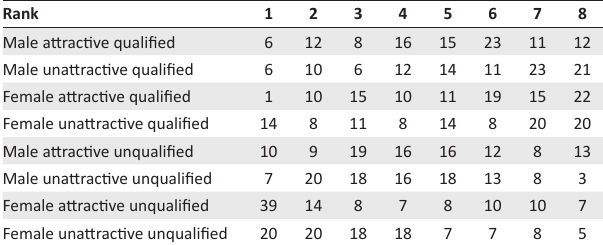
TABLE 3: Frequency of rank per candidate.